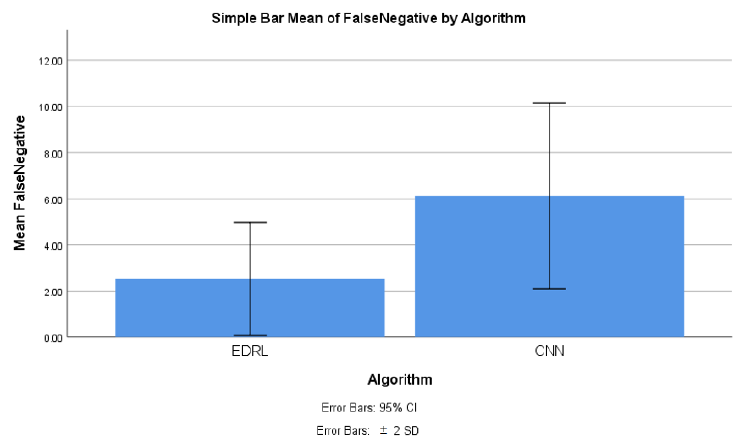
Figure 6. False negative comparison between EDRL and CNN algorithm with stand error bars with SD and confidence